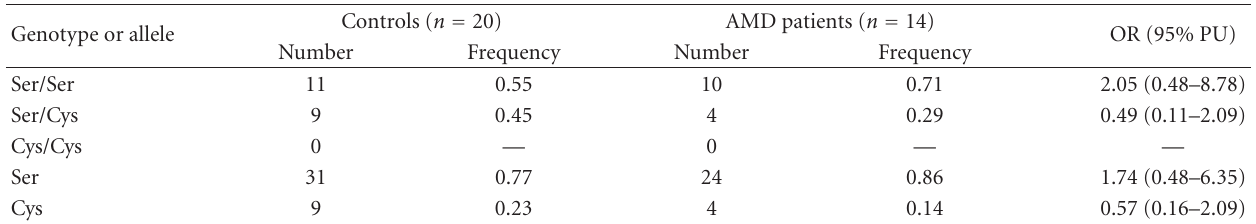
Table 2: The allele and genotype frequencies and odds ratio (OR) of the Ser326Cys polymorphism of the hOGG1 gene in AMD patients and controls with the extent of endogenous oxidative DNA damage higher than the mean for respective group.